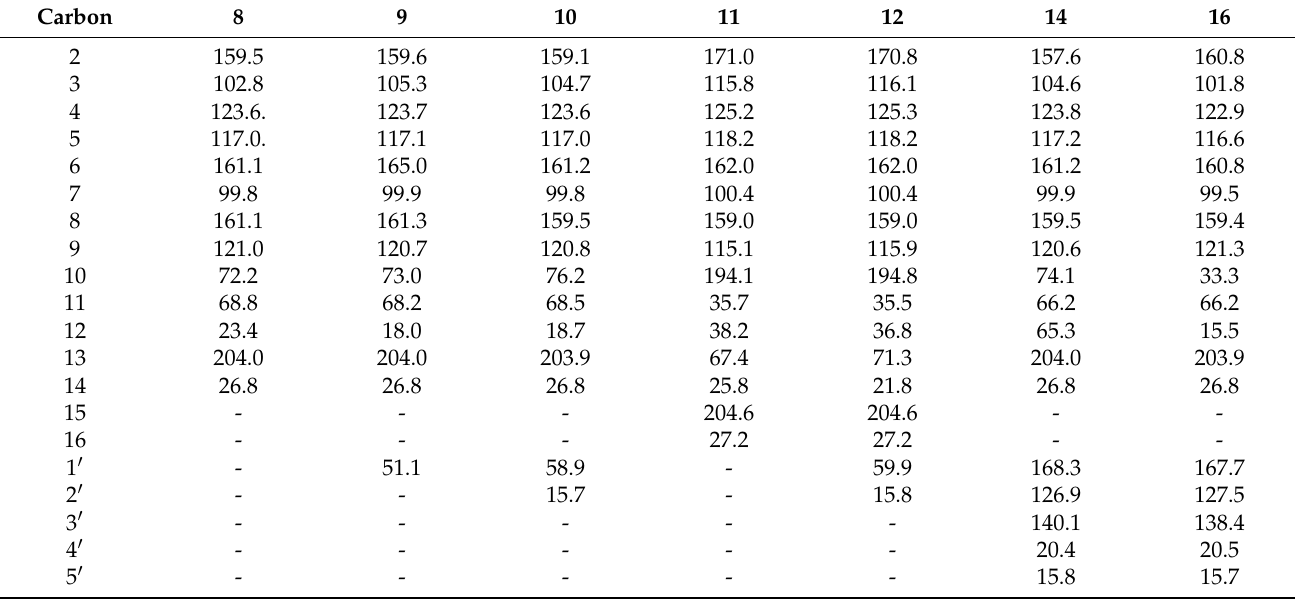
Table 2. 13 C NMR data of compounds 8 – 12 , 14, and 16